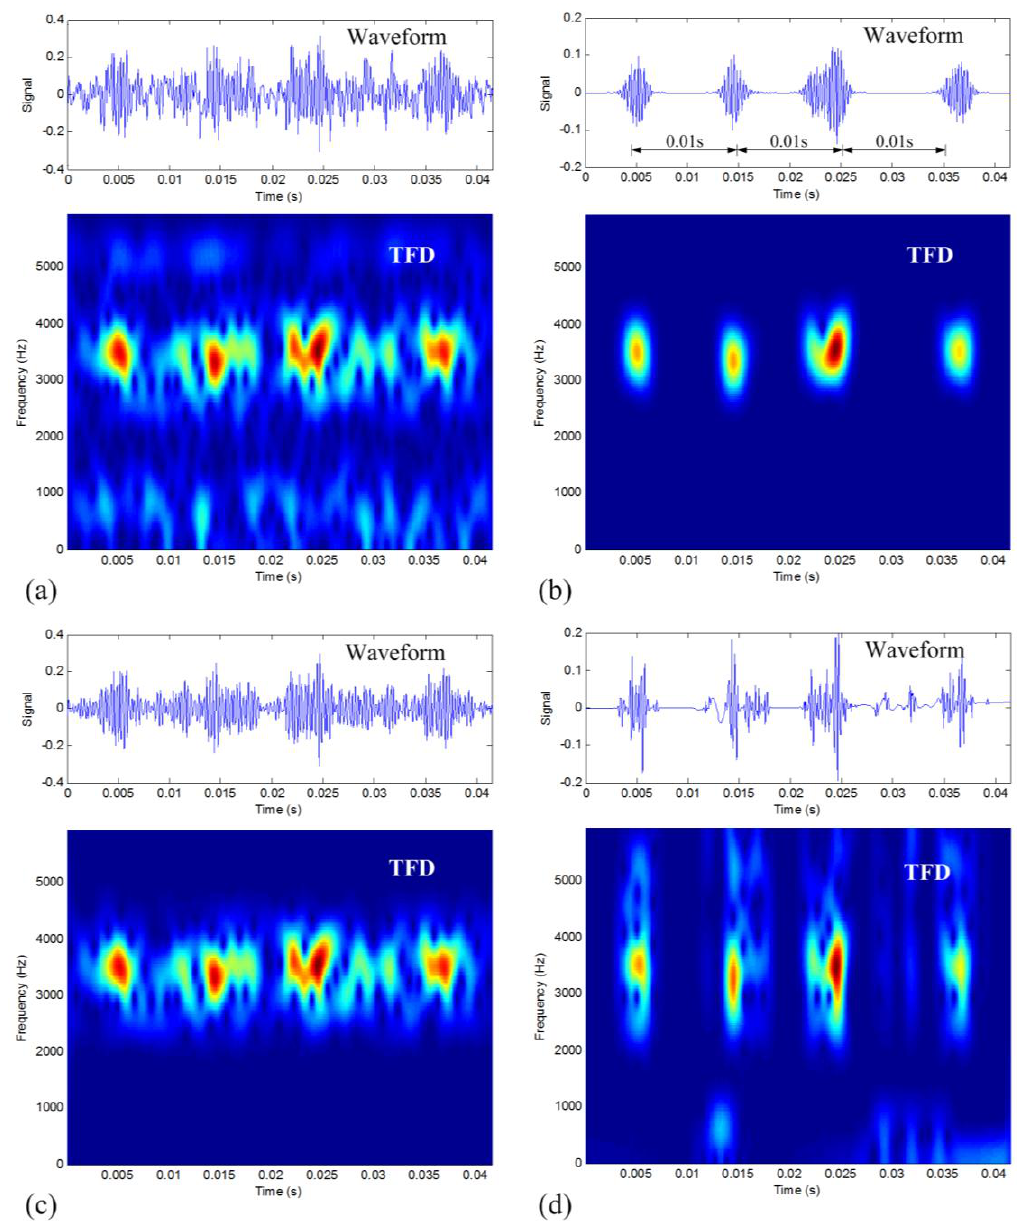
Figure 11. Denoising results of the outer-race defective vibration signal: ( a ) original raw signal; ( b ) the TFM-based denoising result; ( c ) band-pass filtering result; and ( d ) DWT-based denoising result.